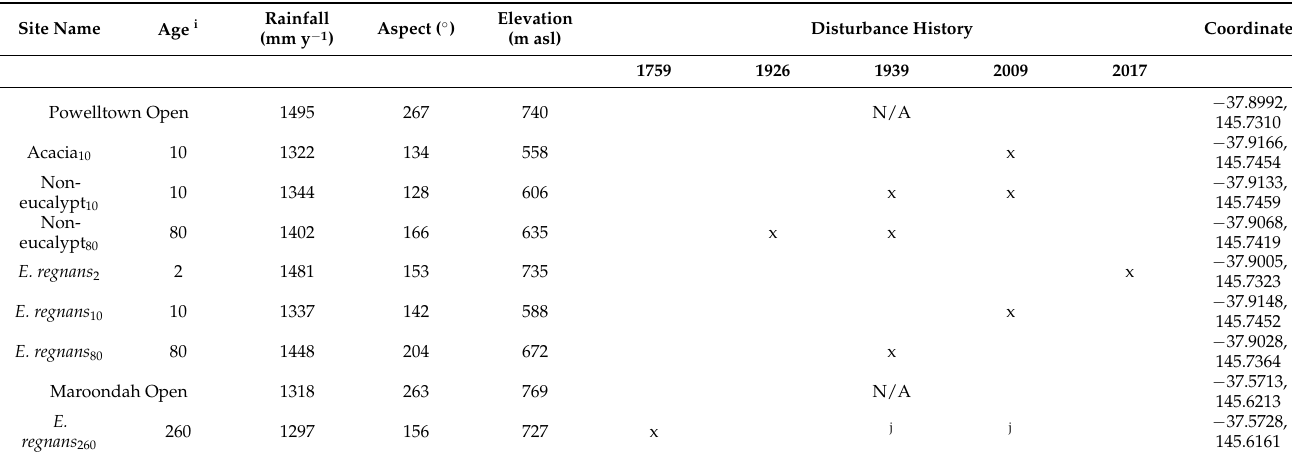
Table 1. Site information of the instrumented plots and open-weather stations. Site data is located below the relevant open weather station (Powelltown Open & Maroondah